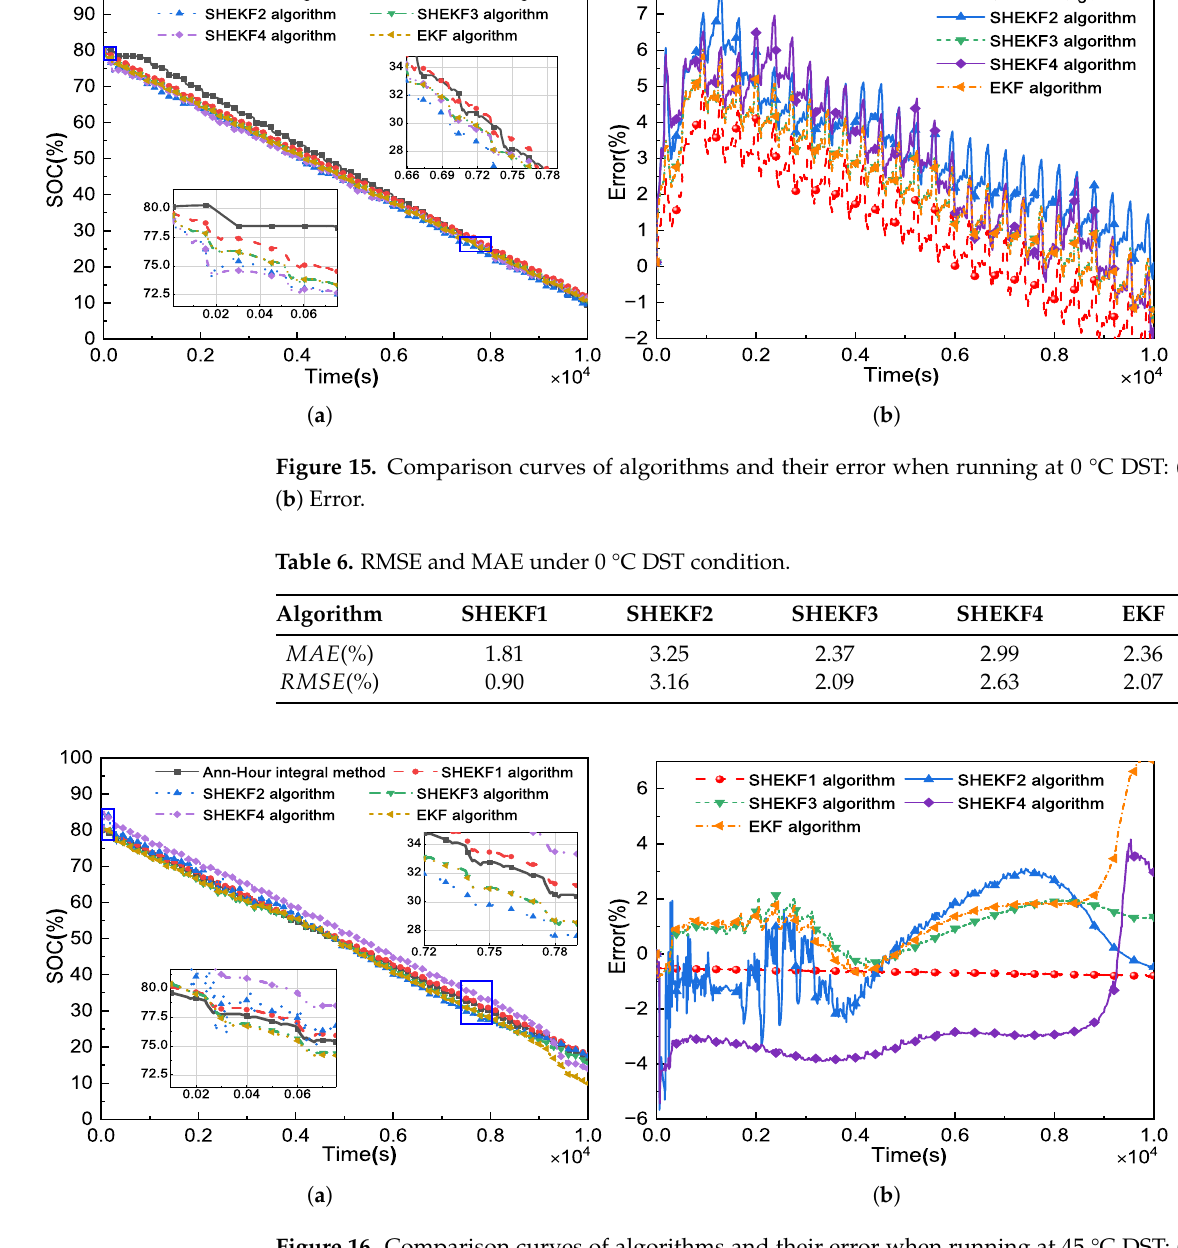
Figure 16. Comparison curves of algorithms and their error when running at 45 °C DST: ( a ) SOC, ( b ) Error. Table 7. RMSE and MAE under 45 °C DST